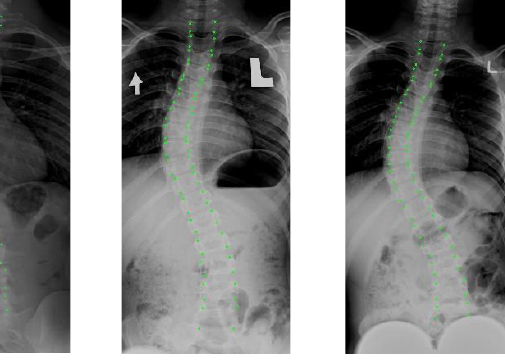
Table 2. Formulas for each evaluation metric.